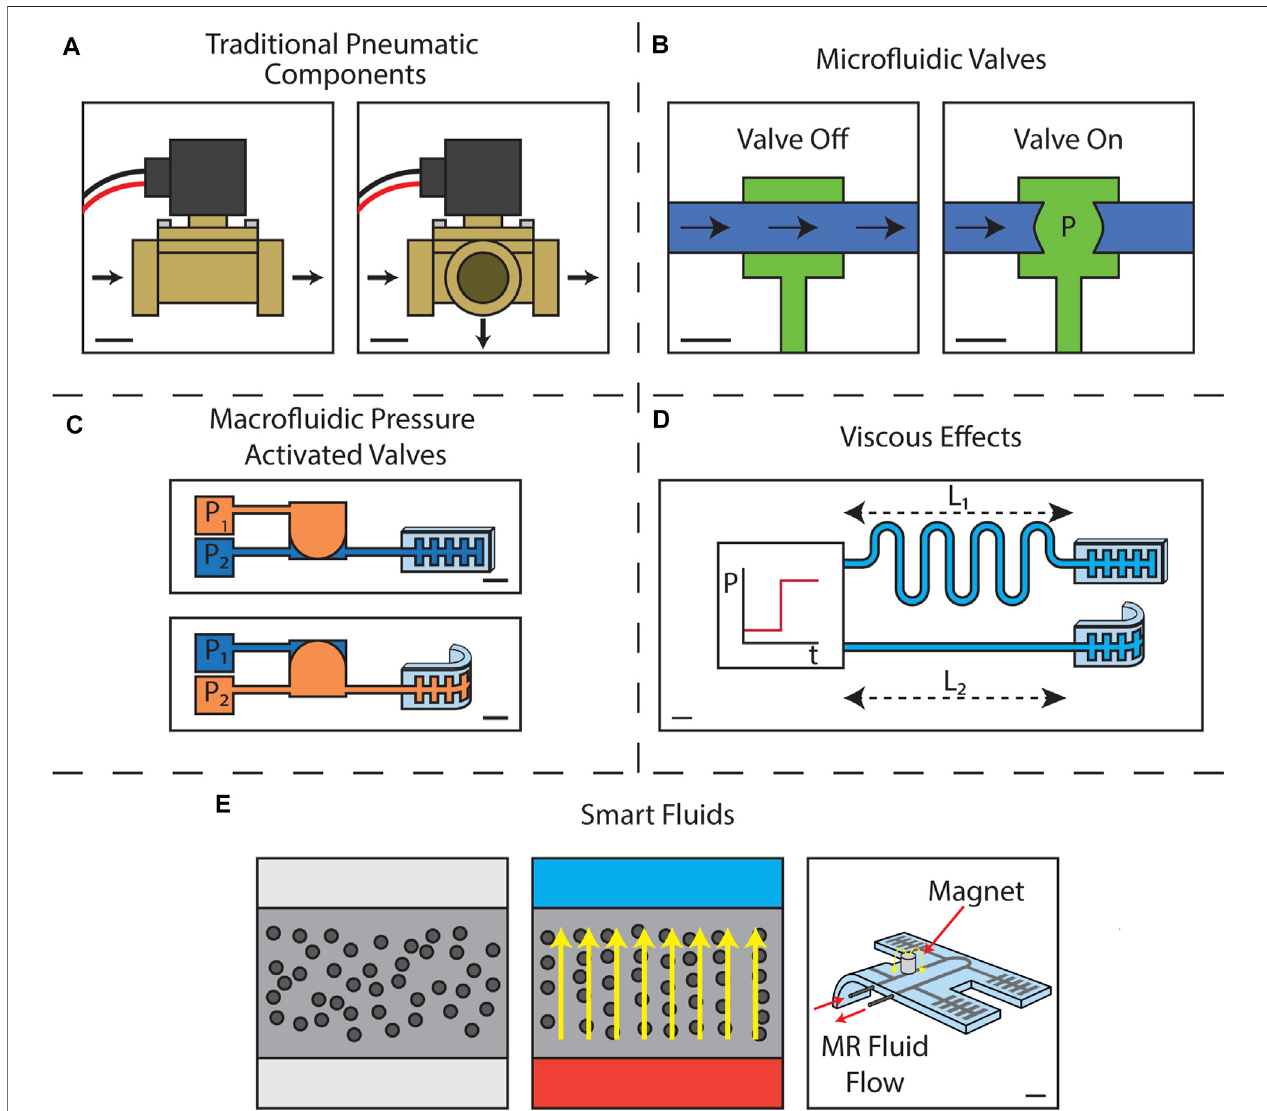
FIGURE 3 | Schematics illustrating the control method types (A) traditional pneumatic components represented by (left) a two-way solenoid valve and (right) a three-way solenoid valve. Scale bars represent 1 cm. (B) micro fl uidic valves represented by a Quake type valve with (left) showing the valve off such that fl ow may pass and (right) showing the valve on such that no fl uid may fl ow. Scale bars represent 1 mm. (C) macro fl uidic pressure activated valves represented by an actuator-scale bistable valve with (top) showing P 1 > P 2 such that the actuator does not bend and (bottom) showing P 1 < P 2 such that the actuator bends. Scale bars represent 1 cm (D) viscous effects represented by two actuators with fl ow channels of length L 1 > L 2 driven by a step function pressure input such that actuator with the shorter fl ow channel bends fi rst. The scale bar represent 1 cm. (E) smart fl uids where (left) shows a smart fl uid in the absence of an applied fi eld (middle) shows the same fl uid with a fi eld applied such that the active particles align along the fi eld lines, and (right) shows a soft robot fi lled with a continuously fl owing MR fl uid such that one of its actuators bends with the application of a magnetic fi eld downstream. The scale bar in the right image represents 1 cm. The left two images are not drawn to scale.